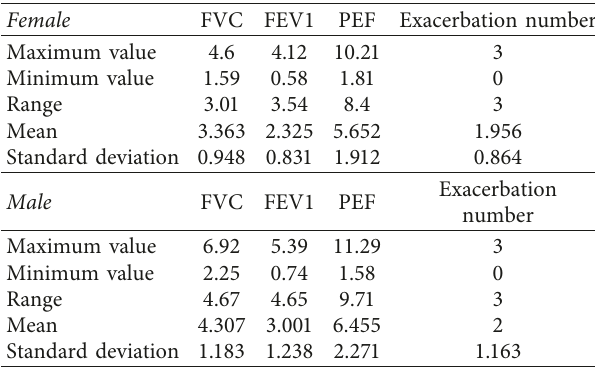
Table 1: Descriptive statistics of lung function and